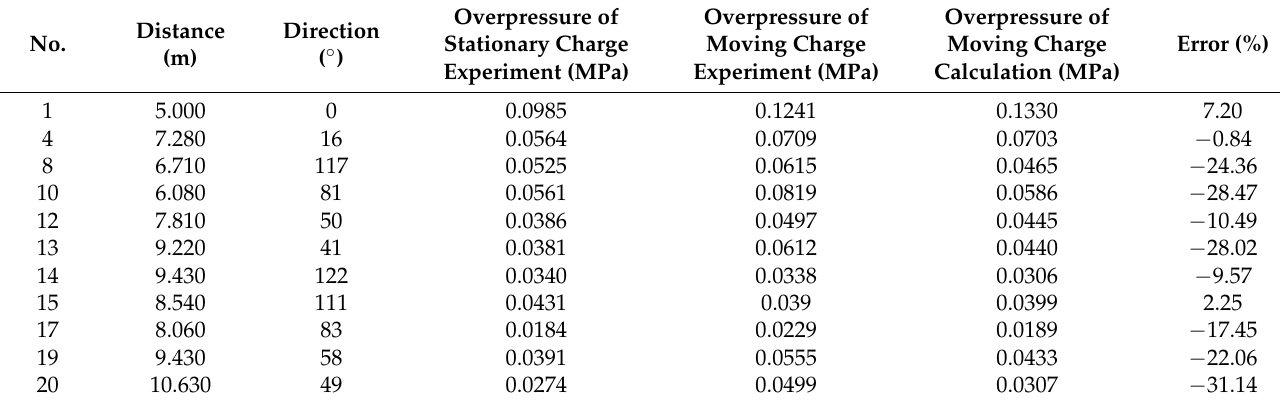
Table A5. Experimental and calculated shock wave